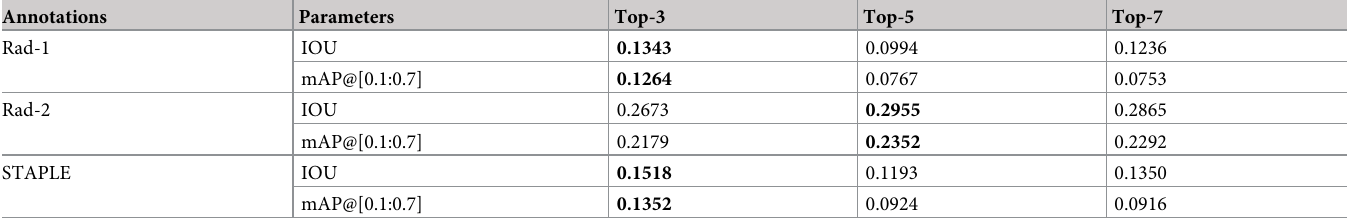
Table 9. IOU and mAP values obtained with top-3, top-5, and top-7 ensembles using annotations of Rad-1, Rad-2, and STAPLE-generated consensus ROI annotations.